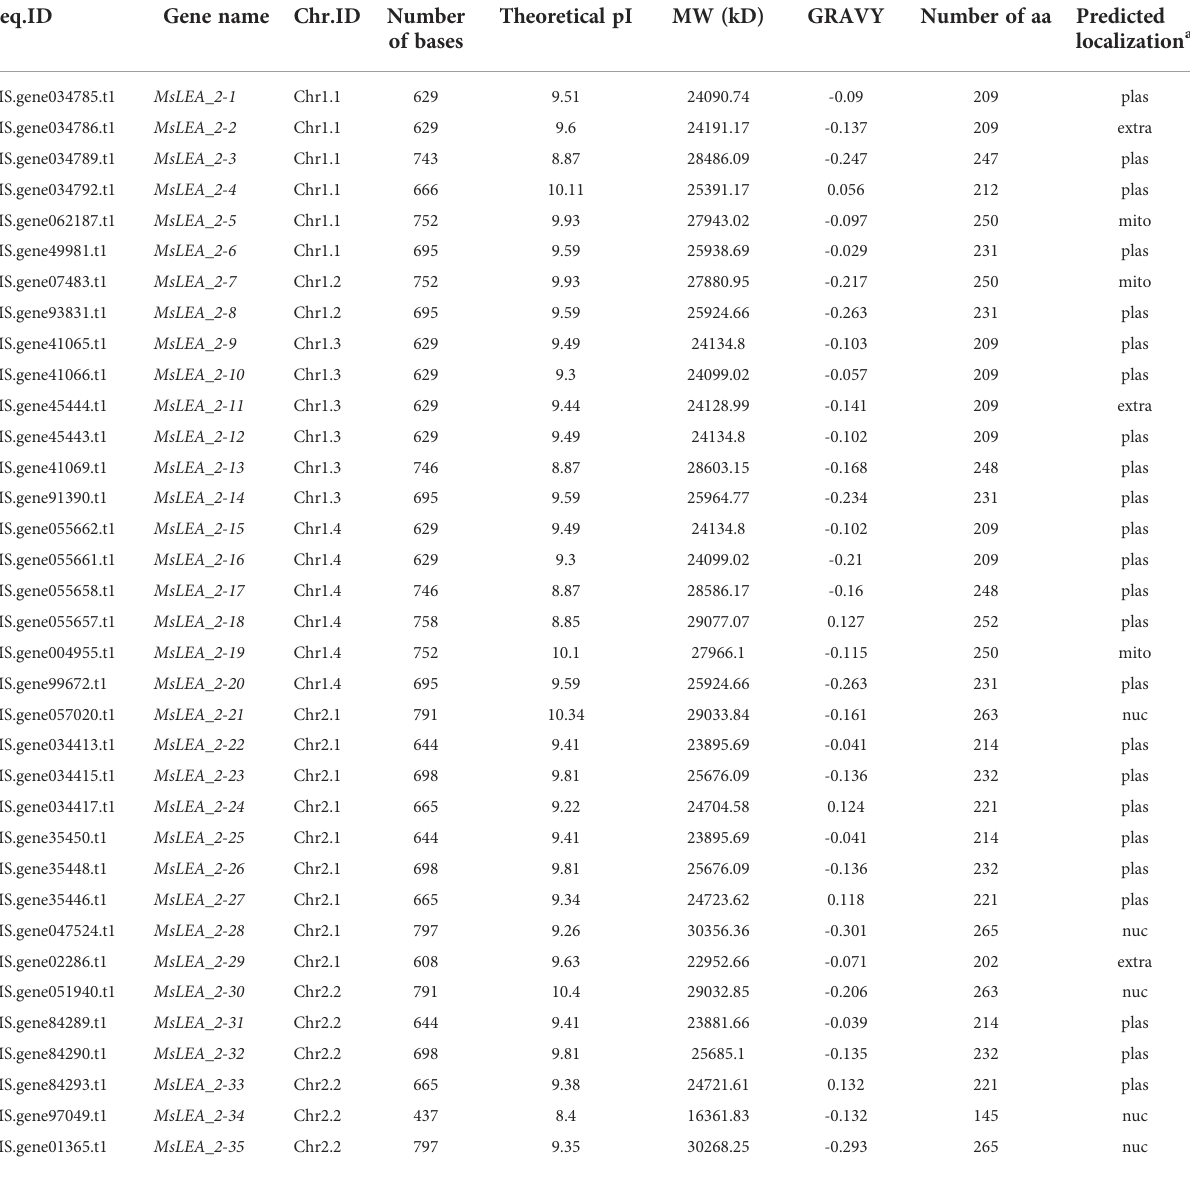
TABLE 1 Prediction characteristic information table of MsLEA _ 2 gene family proteins.